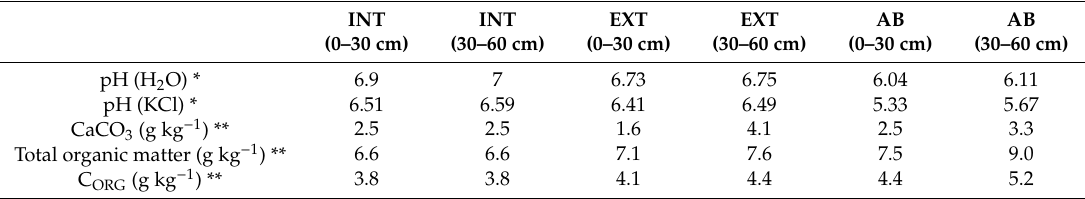
Table 1. Agrochemical and physical parameters of the composite (of five soil sampling points) soil